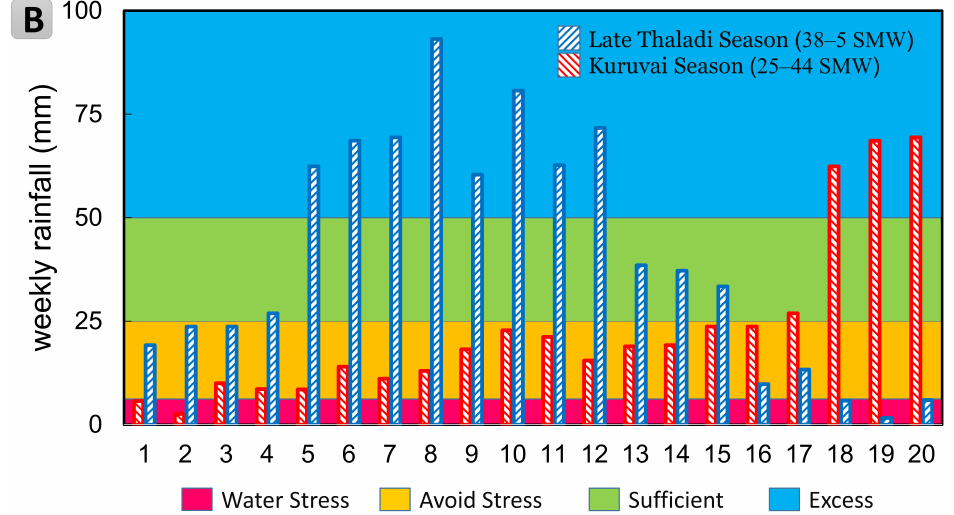
Figure 5. Average weekly rainfall distribution during major rice-growing seasons in ( A ) Sadivayal and ( B )